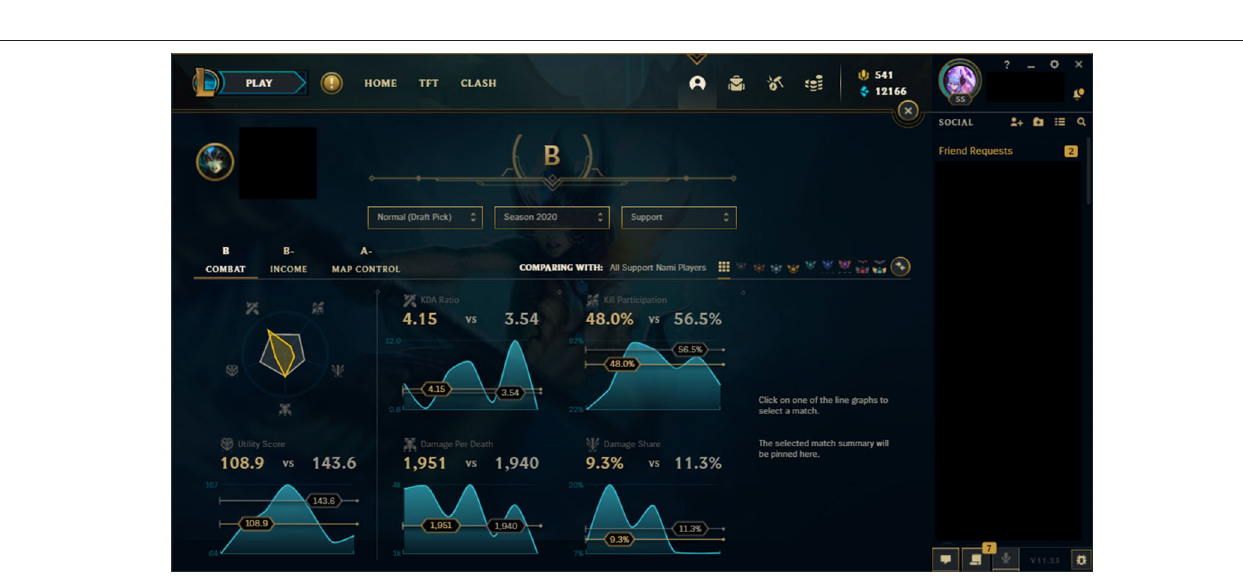
FIGURE 5 | The game client stores and aggregates statistical data to present players with overviews of their gameplay over time. Image reproduced with permission from Riot Games Inc. This image is copyrighted to Riot Games